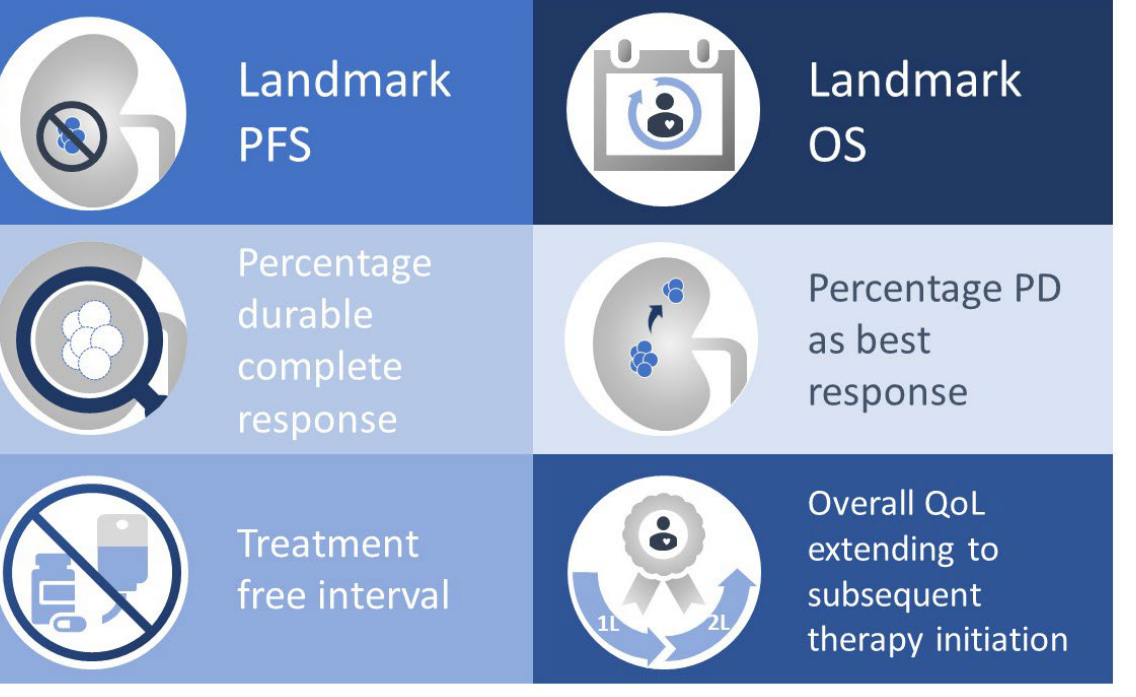
Figure 4. Potential endpoints for future registrational strategies. OS, overall survival; PD, progressive disease; PFS, progression-free survival; QoL, quality of life.